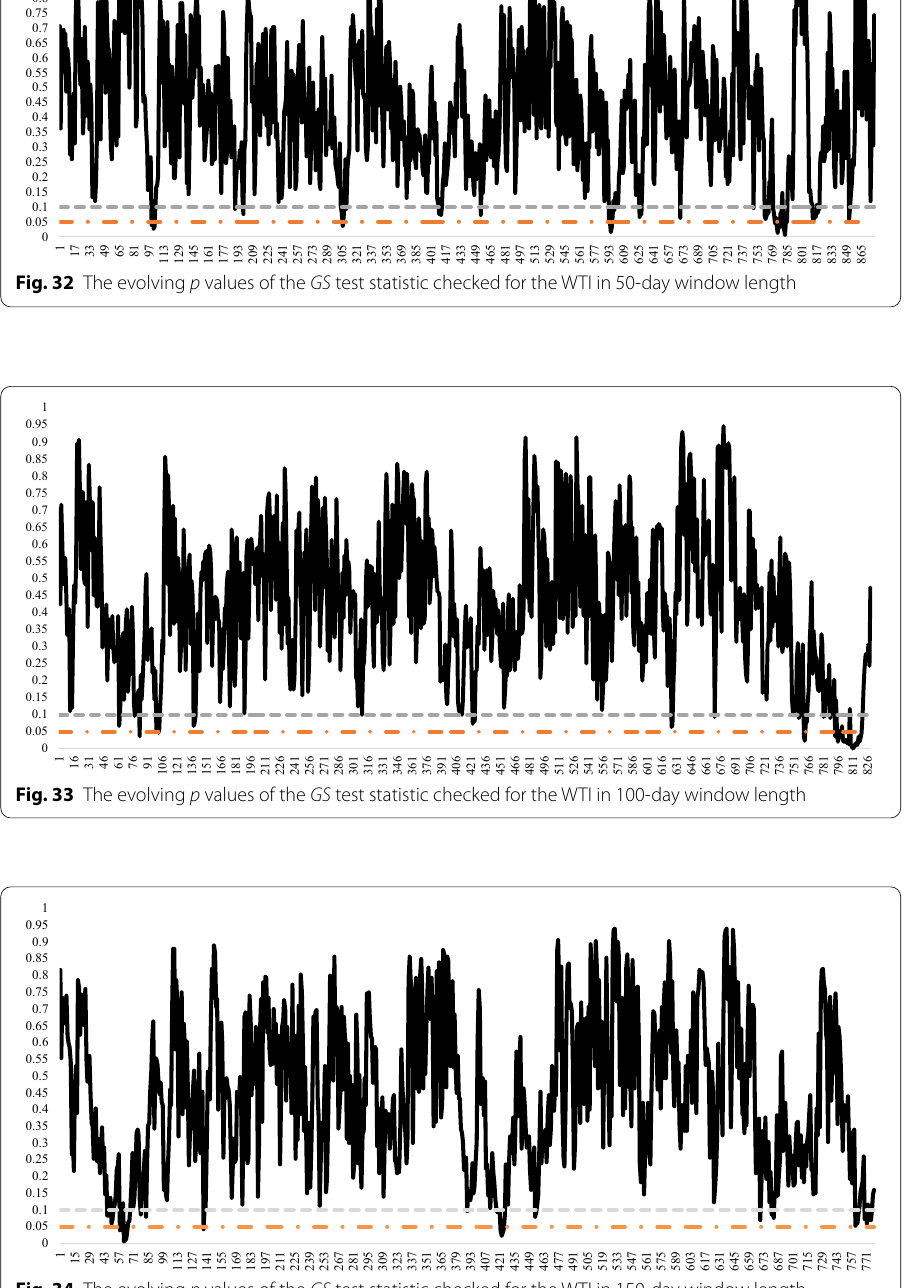
Fig. 34 The evolving p values of the GS test statistic checked for the WTI in 150-day window